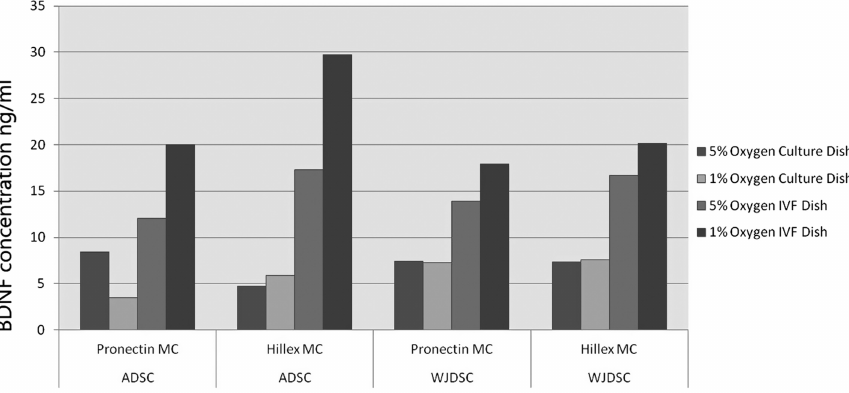
Figure 4. Graph of BDNF concentrations in ADSC and WJDSC hillex/pronectin microcarrier, 1%/5% oxygen and culture dish/in vitro fertilization dish groups. BDNF, brain-derived neurotrophic factor; ADSC, adipose-derived stem cell; WJDSC, Wharton’s jelly-derived stem